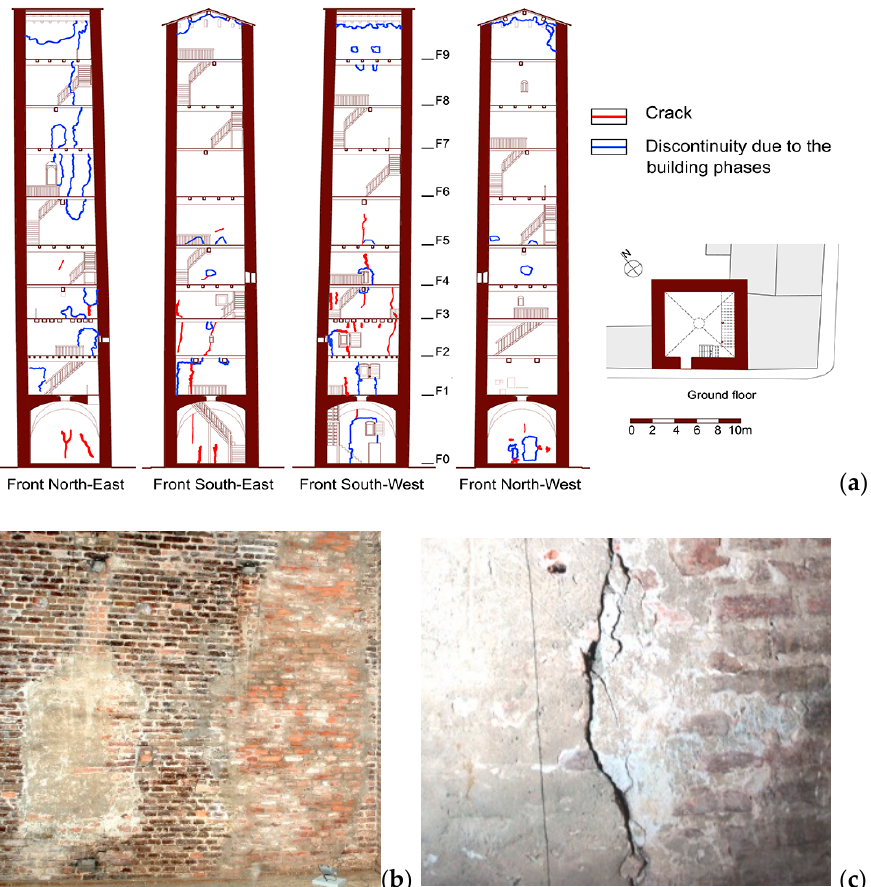
Figure 4. Section of the Zuccaro’s Tower in Mantua with the survey of the crack pattern and of the discontinuities ( a ); the masonry appears fragmentary ( b ); minor structural movements could detach local discontinuities, propagating cracks ( c ).